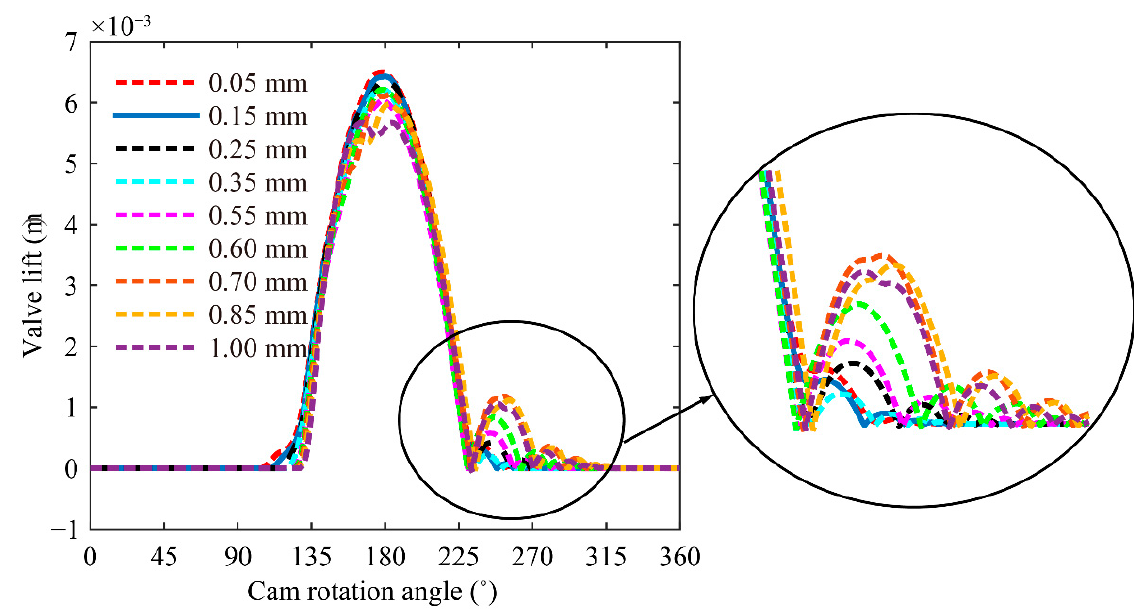
Figure 8. Comparison of the bounce phenomenon at different valve clearances.